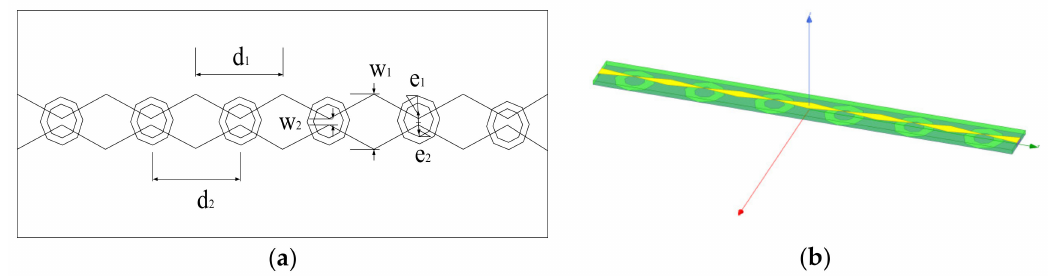
Figure 5. ( a ) Perspective view of a microstrip band stop filter etching of a periodic octagon ring EBGs; ( b ) 3D picture of a microstrip band stop filter etching of a periodic octagon ring